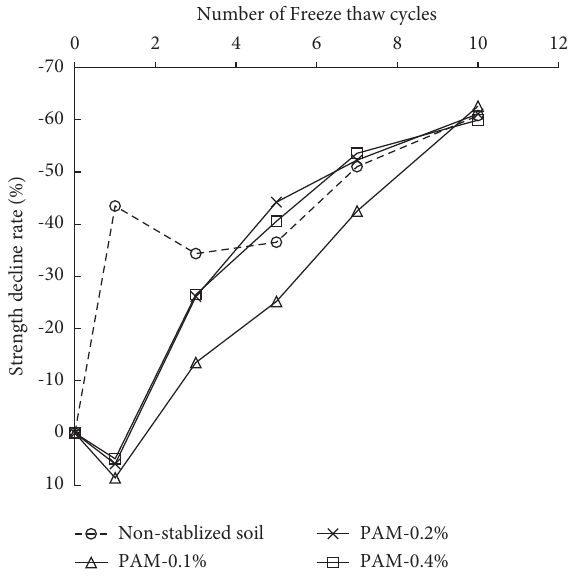
Figure 20: Changes of strength decrease of PAM (low content) stabilized specimens with freeze-thaw cycles.